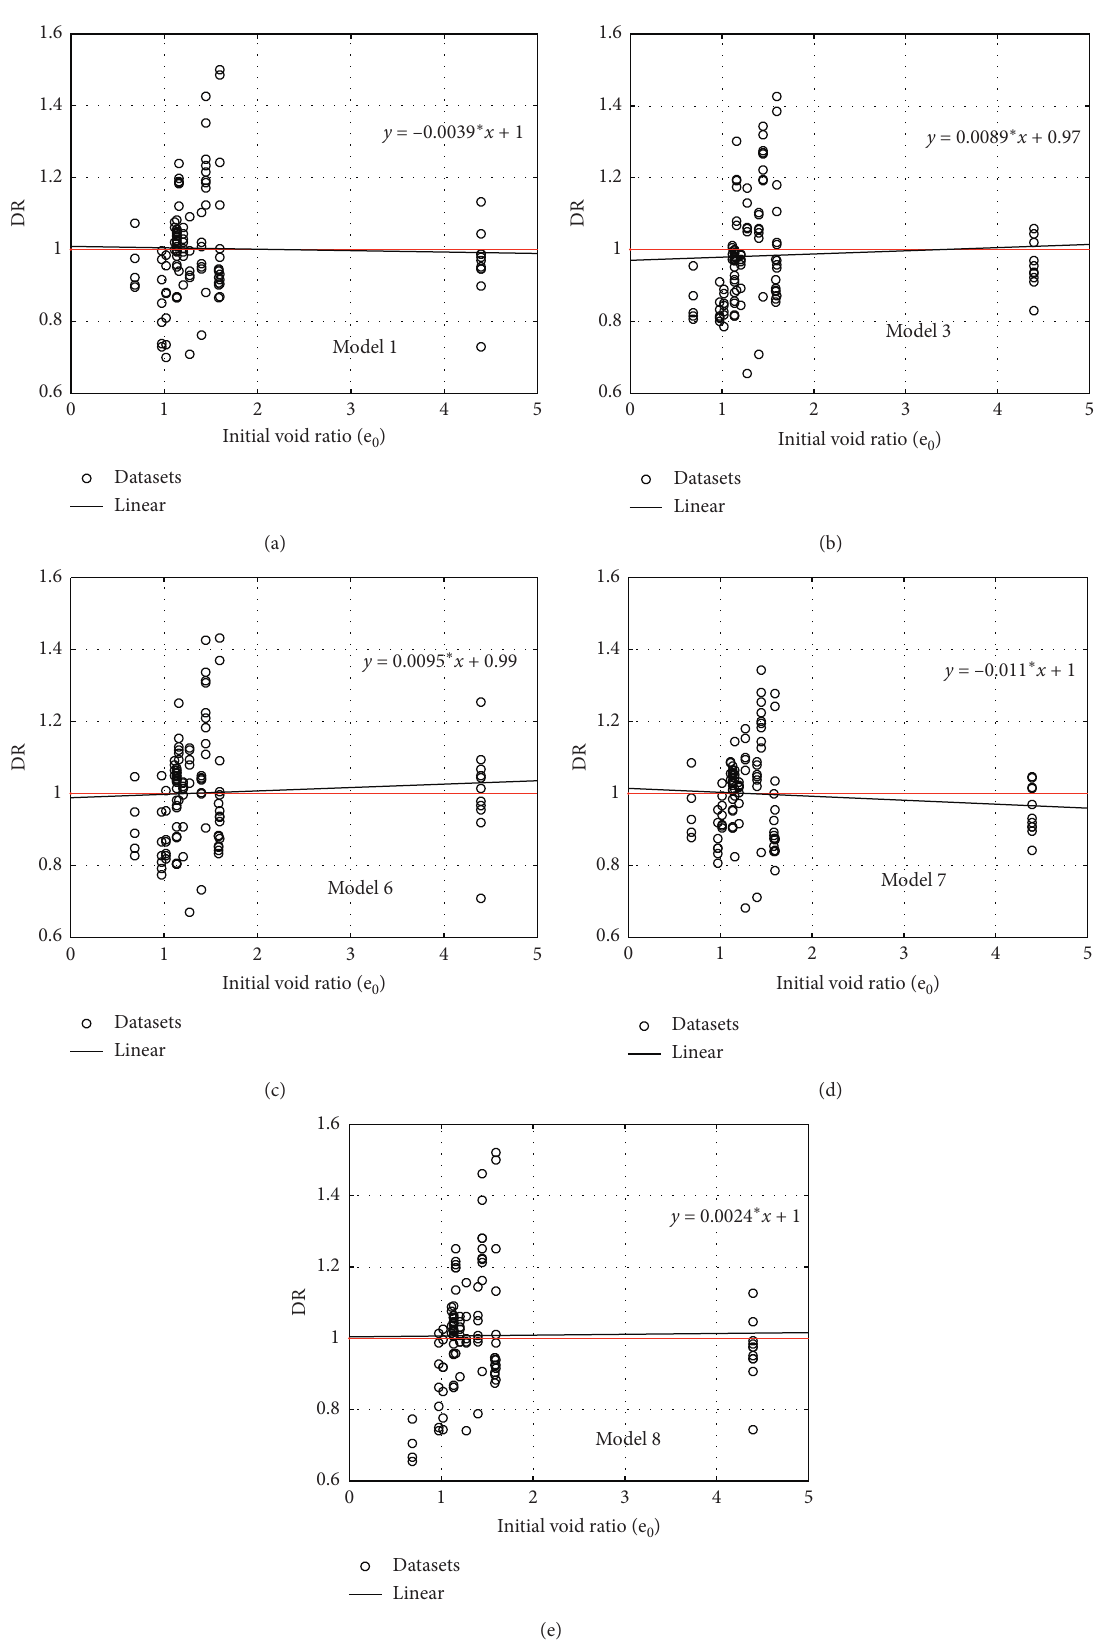
Figure 4: Variation of DR against initial void ratio for (a) Model 1, (b) Model 3, (c) Model 6, (d) Model 7, and (e) Model